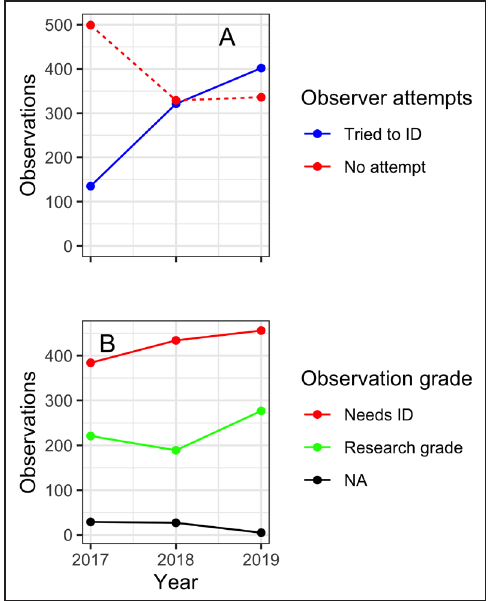
Figure 5 Aspects characterizing the data quality of observations in iNaturalist. (a) Observers increased the number of observations they tried to identify from 2017 to 2019, thus increasing the likelihood that iNaturalist identifiers would find and review